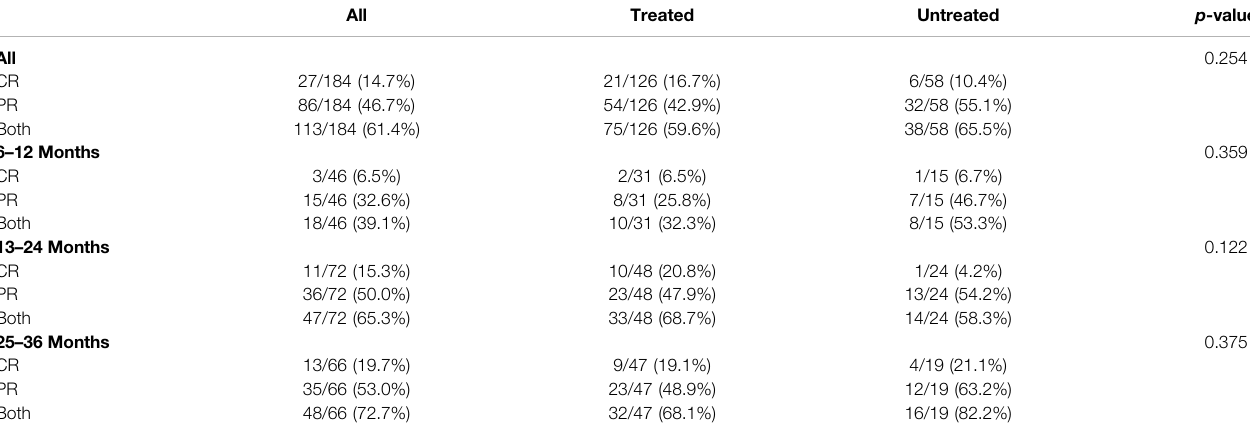
TABLE 2 | Composition of remission rates (grouped by previous use of immunosuppressive therapy). All Treated Untreated